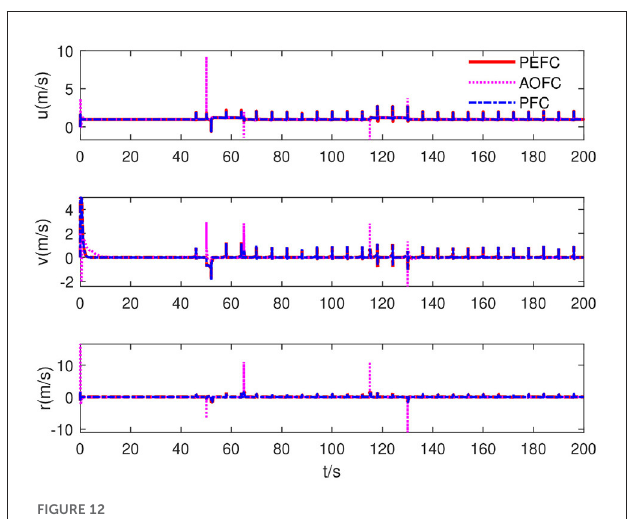
FIGURE12 System velocity